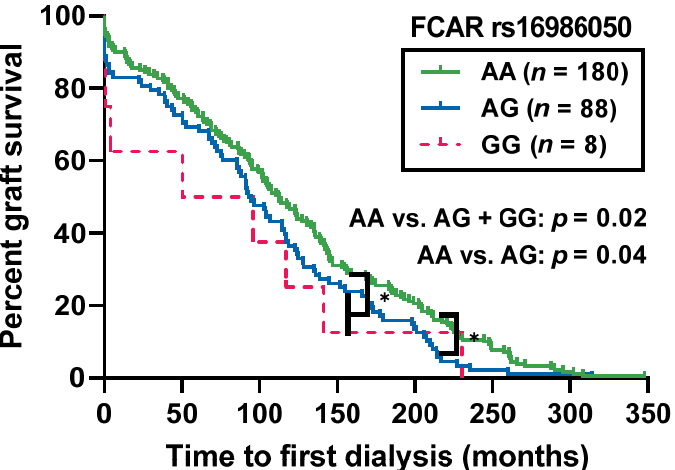
Figure 5. Graft survival in 276 kidney transplant recipients with allograft failure, stratified by an Fc α receptor polymorphism (FCAR rs16986050, 844A/G). The time to first dialysis was used as a measure of the duration of allograft function. Graft survival of various groups was compared by Log Rank (Mantel–Cox) test. * p < 0.05.